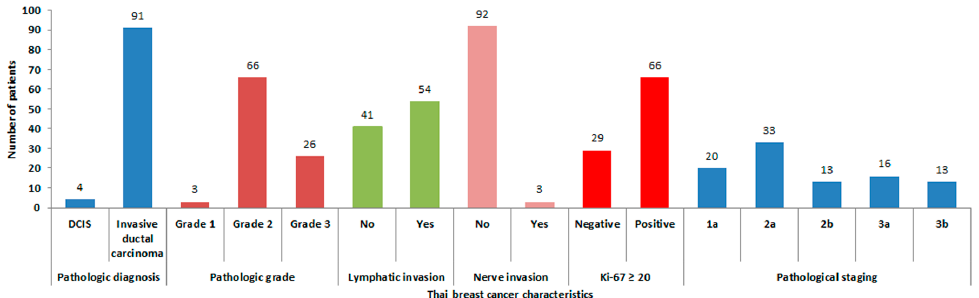
Figure 2. Thai breast cancer patients’ characteristics and staging in this study. DCIS: ductal carcinoma in situ.